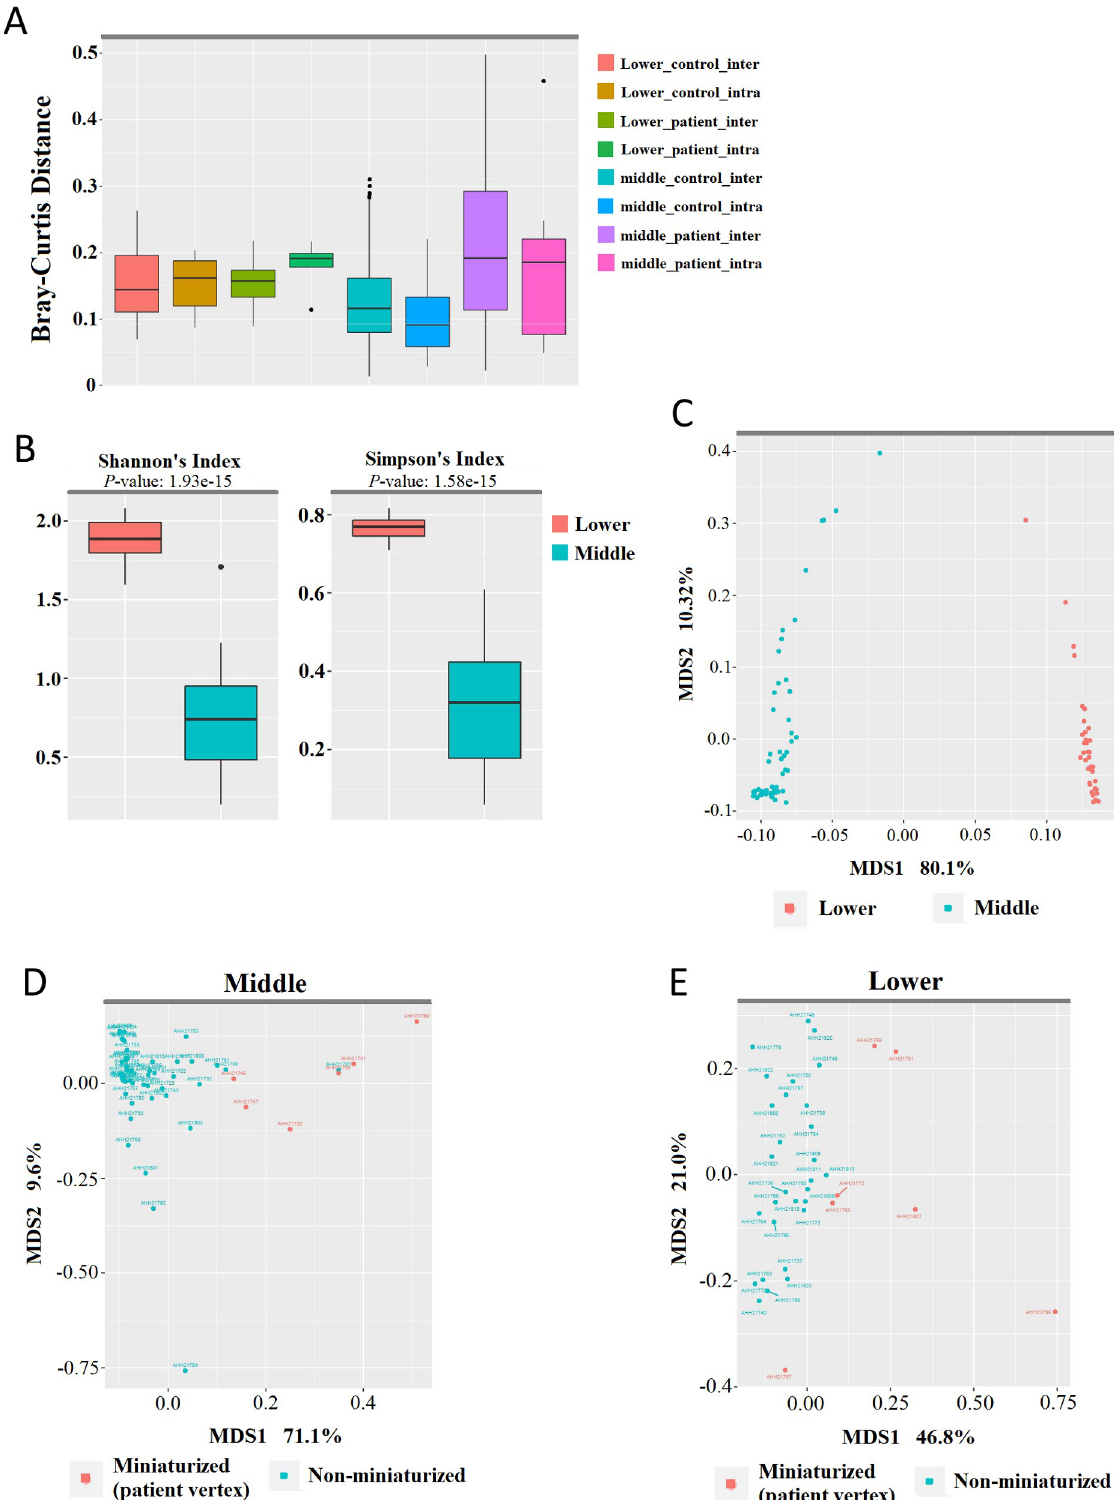
Fig 2. Microbiome profiles of FUE lower and middle portions from AGA patients and healthy controls. (A) Bray-Curtis distances depicting inter and intra-sample dissimilarity of samples from the occipital and vertex regions. (B) Species richness in samples from the lower and middle portions as depicted by Shannon and Simpson’s alpha diversity indices (Mann-Whitney U test, p < 0.005). (C-E).